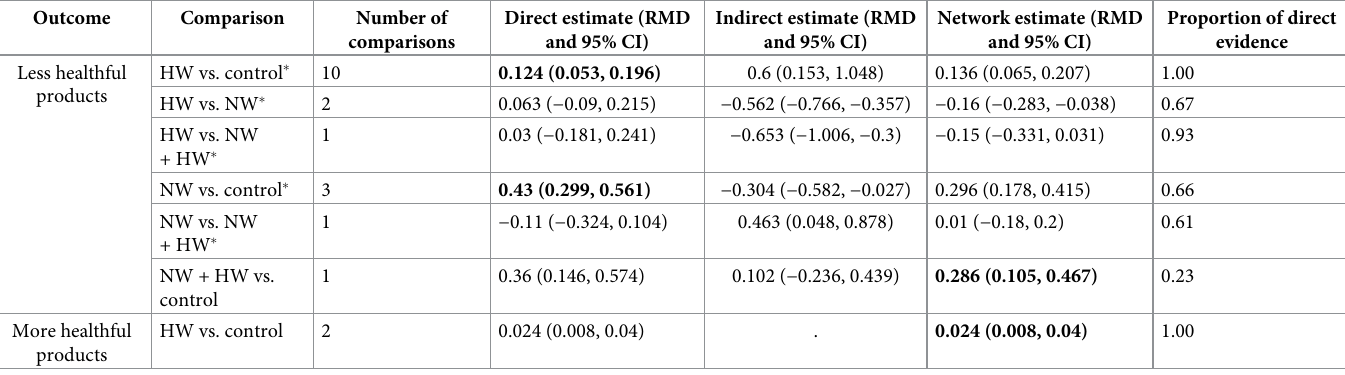
Table 5. The network effects of different label types on the perceived disease risk of consuming